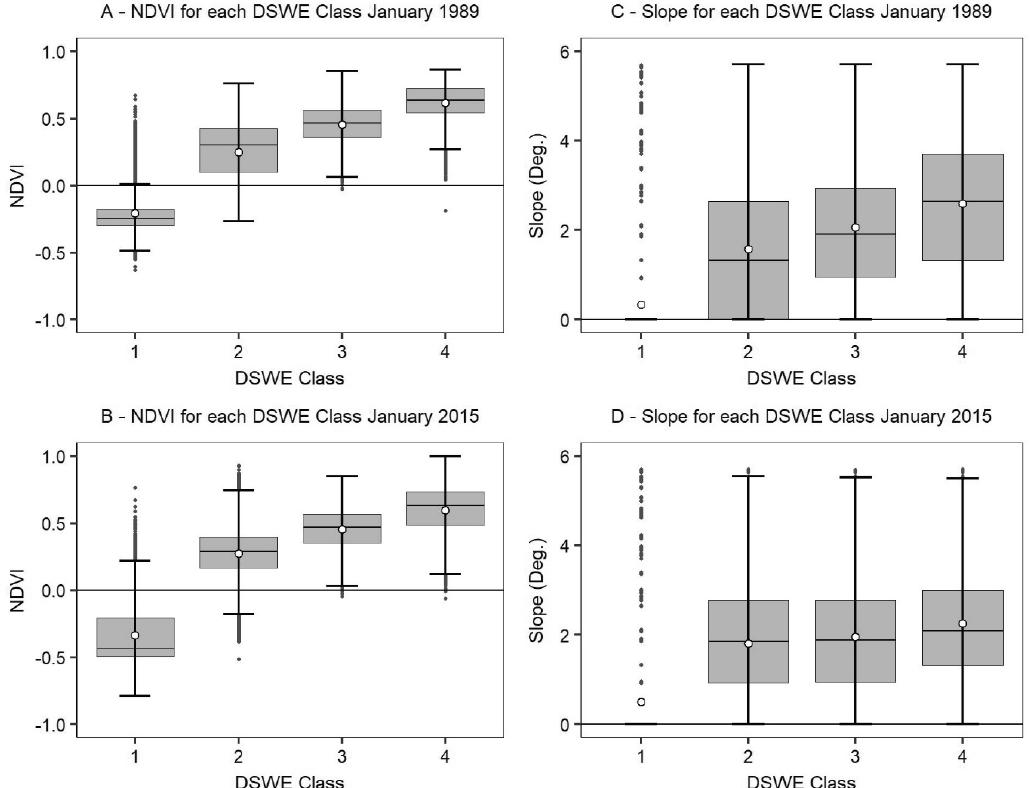
Figure 6. Boxplots of Normalized Difference Vegetation Index (NDVI) values summarized for all DSWE water pixels across Cambodia in January 1989 ( A ) and January 2015 ( B ). Boxplots of slope values derived from Shuttle Radar Topography Mission digital elevation data are also summarized for all DSWE water pixels across Cambodia in January 1989 ( C ) and January 2015 ( D ). Consolidated DSWE classes are 1 (high-confidence water), 2 (moderate-confidence water), 3 (potential wetland), and 4 (low-confidence water). The black horizontal line in each boxplot represents the median NDVI, the lower and upper box edges represent the first and third quartiles, respectively, and the whiskers represent the data minimum and maximum. The white circle in each plot is the mean for that class.